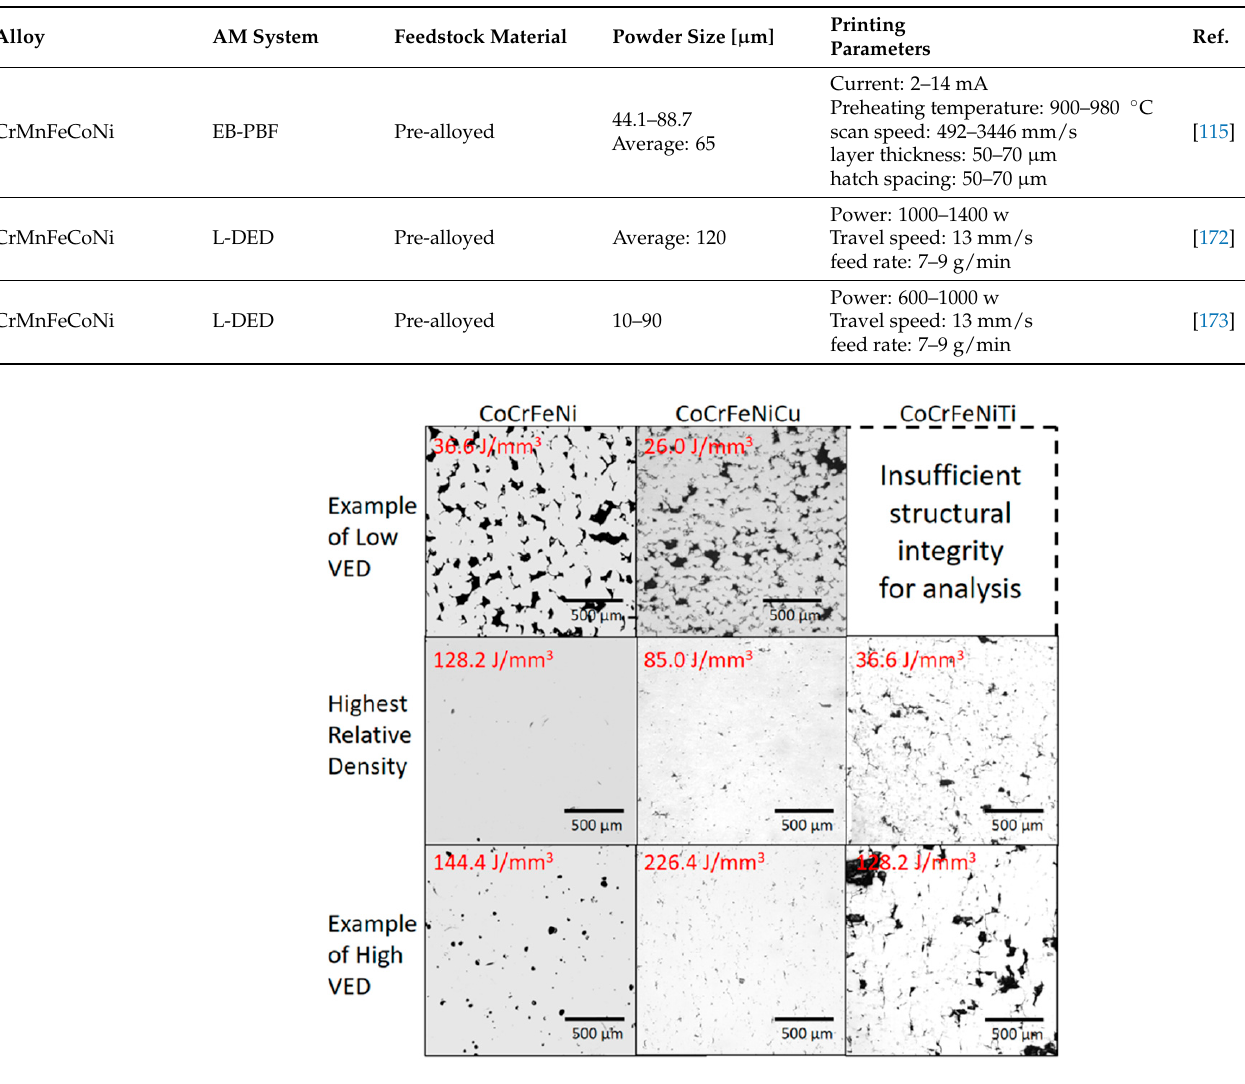
Figure 17. Optical microscopy showing the relative density of three HEA compositions in low, op- timal, and high VED (VED values presented in red), Farquhar et al.